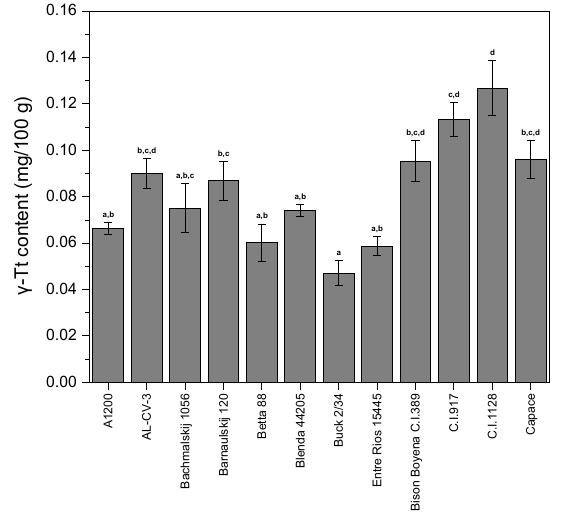
Fig. 2 Gamma-tocotrienol (γ-Tt) content in varieties of flax from across the world (Group II). Different letters indicate significant differences (Tukey’s HSD multiple comparison test, α = 0.05).